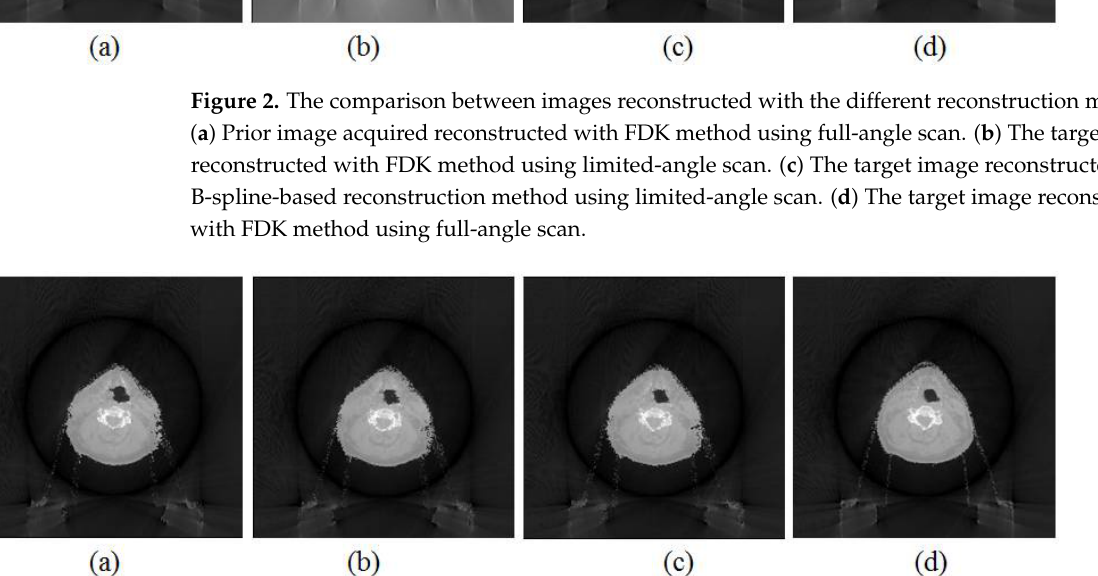
ods. ( a ) Prior image acquired reconstructed with FDK method using full-angle scan. ( b ) The target image reconstructed with FDK method using limited-angle scan. ( c ) The target image recon- structed with B-spline-based reconstruction method using limited-angle scan. ( d ) The target image reconstructed with FDK method using full-angle scan.